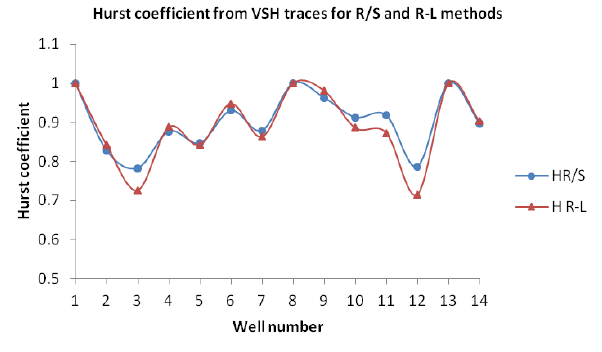
Fig. 3. Fractal behavior for the VSH traces, applying Rescaled-Range and Roughness-Length methods. Range and Roughness-Length methods.